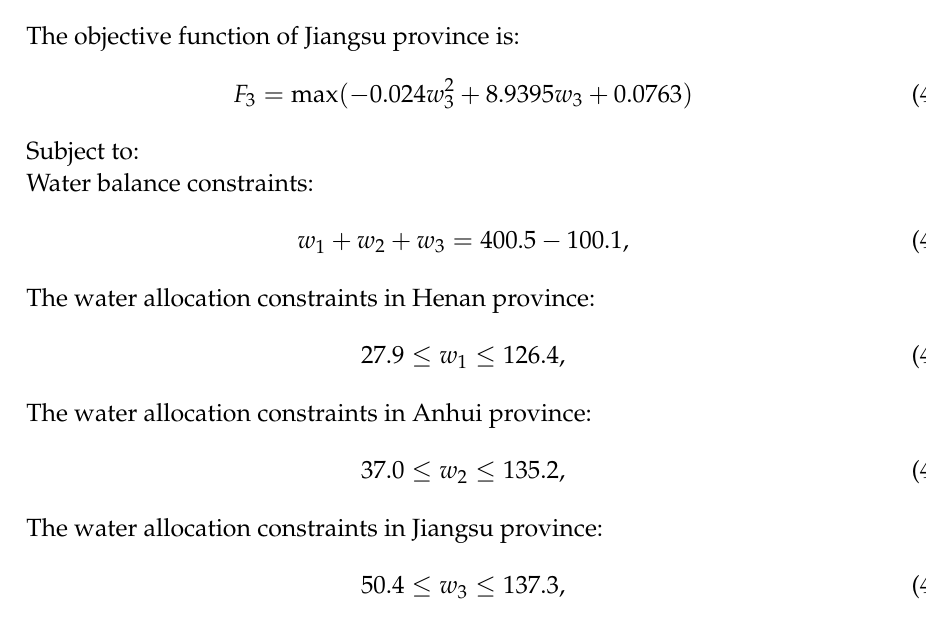
Figure 5. Pareto front of multi-objective optimization based on the AR-MOEA method in the Huaihe River basin.